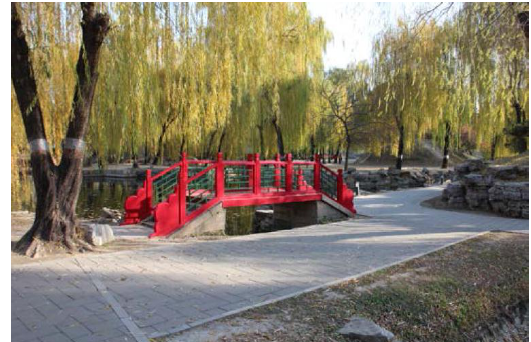
Figure 3. Architectures and structures which affect palace